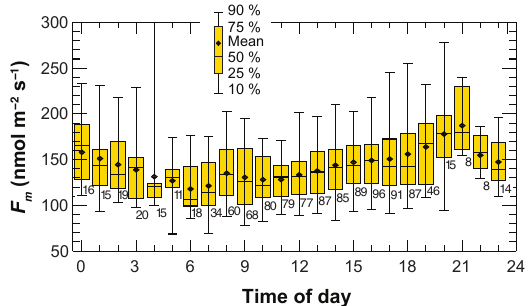
Figure 7. The ensemble-averaged diurnal course of measured CH 4 fluxes from the EC-2 system in